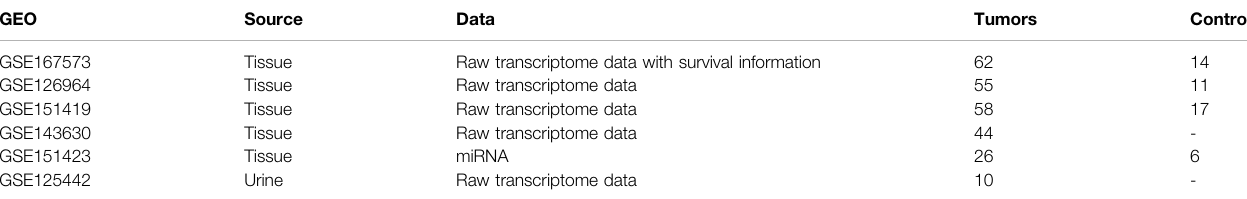
TABLE 1 | Detailed information of GEO